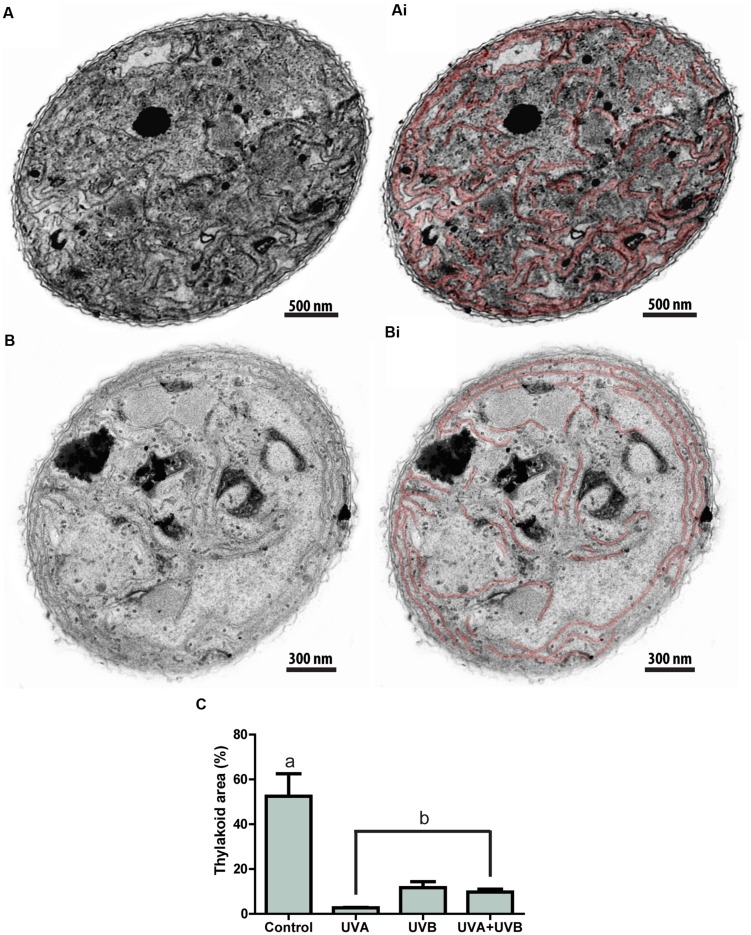
Cyanobacterium thylakoid membranes are drastically affected by UV radiation. While the cytoplasm of control (A), untreated Cylindrospermopsis raciborskii shows a high amount of thylakoid membranes, these structures were greatly reduced after exposure to UV radiation (B). Membranes are highlighted in red in (Ai) and (Bi). In (C), quantitative analyses show a significant reduction of thylakoid areas induced by all UV treatments. Letters indicate a significant difference (P < 0.05). Cells were fixed in a mixture of glutaraldehyde and paraformaldehyde and prepared for TEM. A total of 64 electron micrographs were evaluated and thylakoid areas measured using software Image J 1.41.